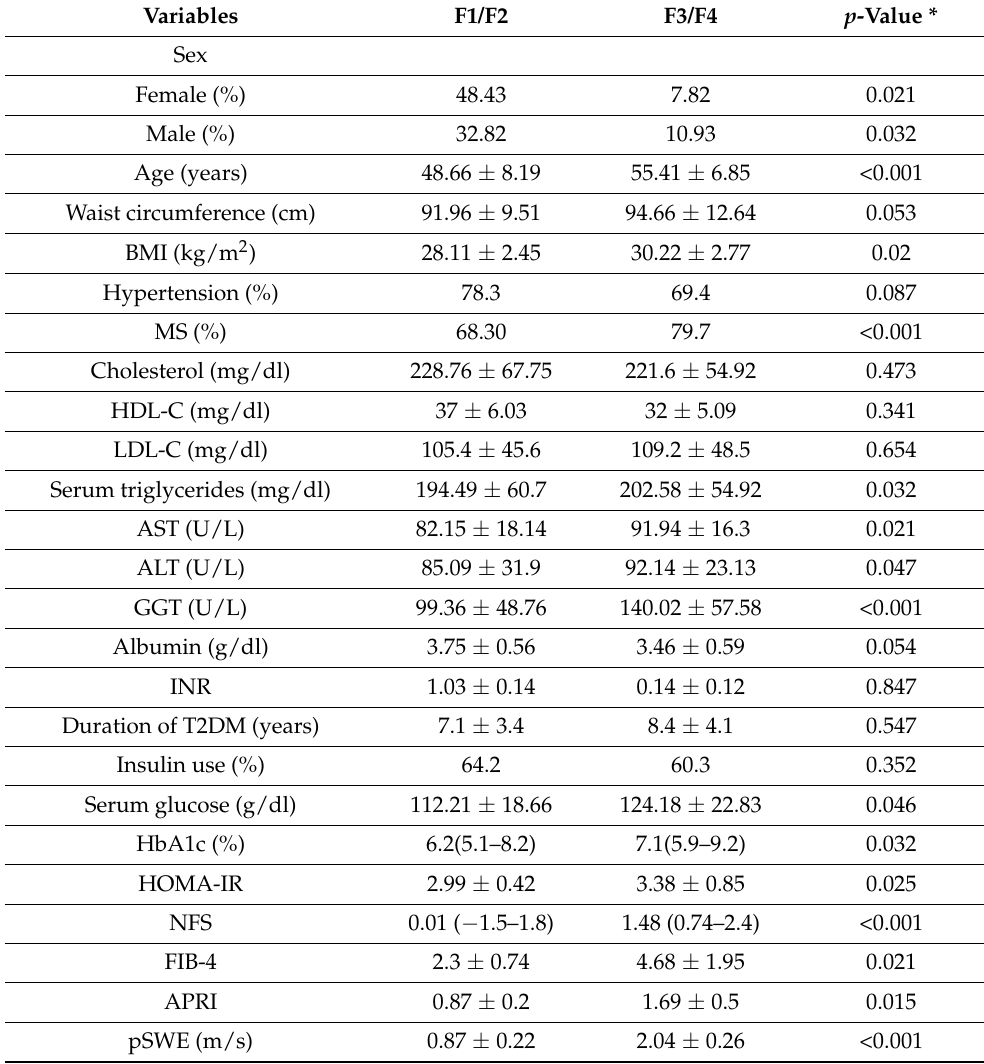
Table 2. Comparison of clinical and biochemical parameters.